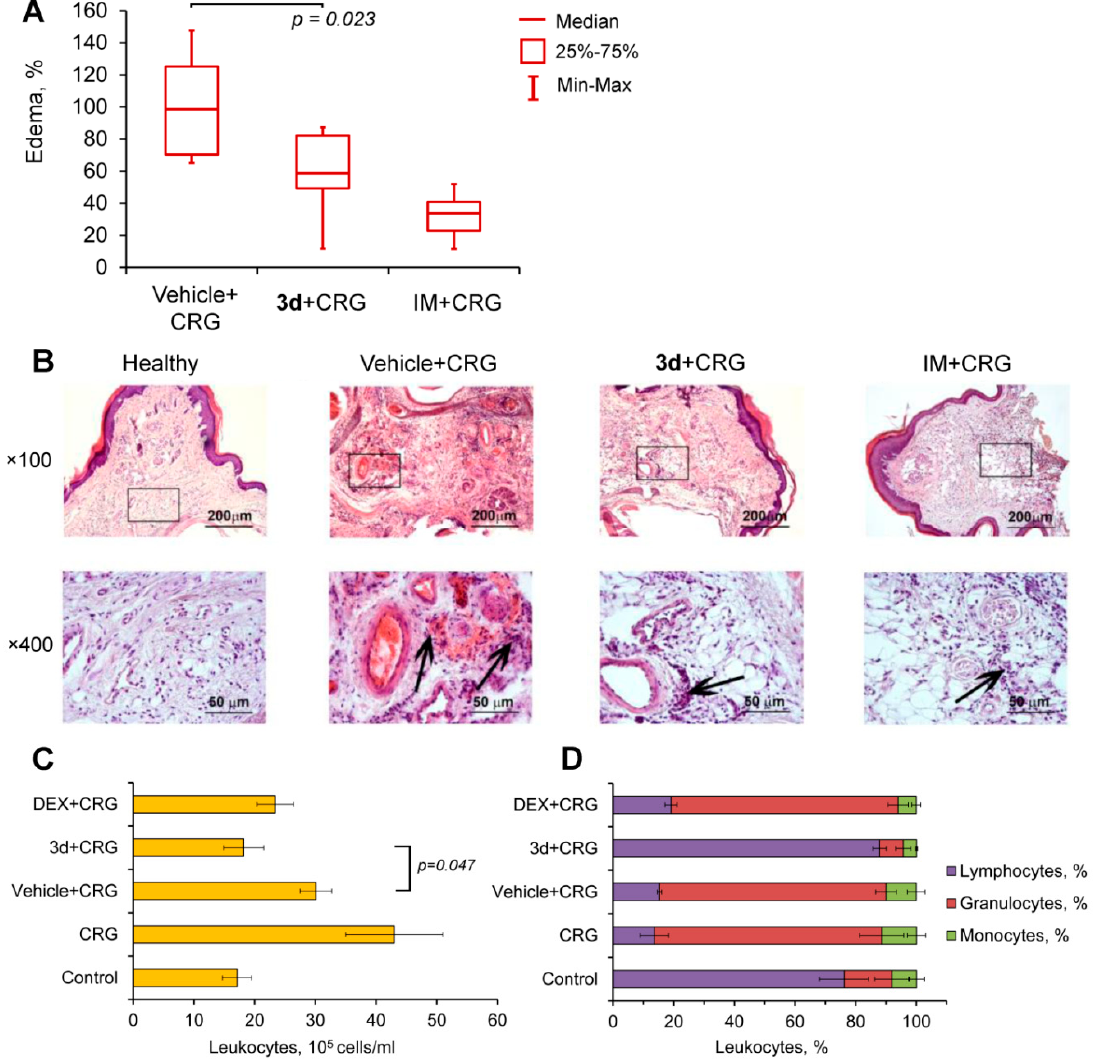
Figure 6. Compound 3d effectively inhibits carrageenan-induced inflammation in vivo. ( A ) Compound 3d suppresses carrageenan-induced paw edema in mice. Compound 3d (50 mg/kg) was administered in sesame oil (vehicle) to mice via gastric gavage 1 h prior to carrageenan (CRG) injection, followed by the measurement of edema weight 5 h after induction of paw inflammation. Indomethacin (IM, 20 mg/kg) was used as a reference drug. ( B ) Histology of healthy footpads and footpads with carrageenan-induced paw edema after administration of 3d , IM, and vehicle. Hematoxylin and eosin staining. Original magnification of ×100 (top panel) and ×400 (bottom panel). The arrows indicate inflammatory infiltration of paw tissues. Black boxes show areas that were examined further at a higher magnification. ( C ) Compound 3d inhibits carrageenan-induced peritonitis in mice. Compound 3d (50 mg/kg) in 10% Tween-80 (vehicle) was intraperitoneally injected into mice 1 h prior to peritonitis induction, followed by the counting of leukocytes in peritoneal fluid. Control–uninflamed mice injected only by saline. Dexamethasone (DEX, 1 mg/kg) was used as a reference drug. ( D ) Compound 3d blocks neutrophil migration into